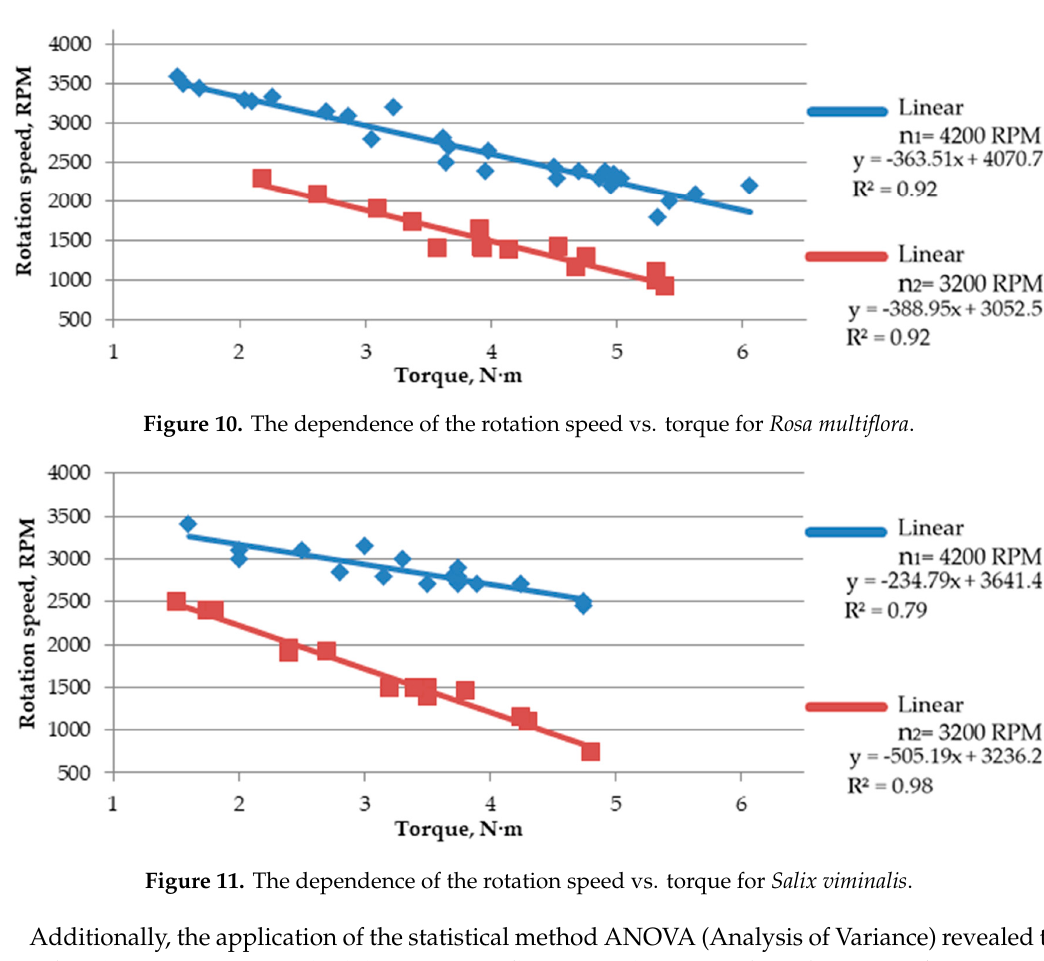
Figure 9. The dependence of rotation speed to torque for Miscanthus × giganteus .